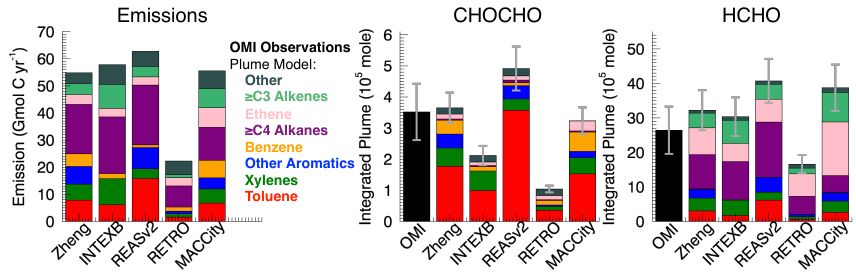
Figure 5. VOC emissions in the PRD from five different inventories (see text), and corresponding plume amounts of CHOCHO and HCHO as computed from the plume model discussed in the text and integrated from t = 5 to t = 20h on the trajectory time grid shown in Fig. 4. Model uncertainty bars are from uncertainties in OH concentrations and photolysis rates (see text). OMI observations integrated on the same trajectory grid are also shown.